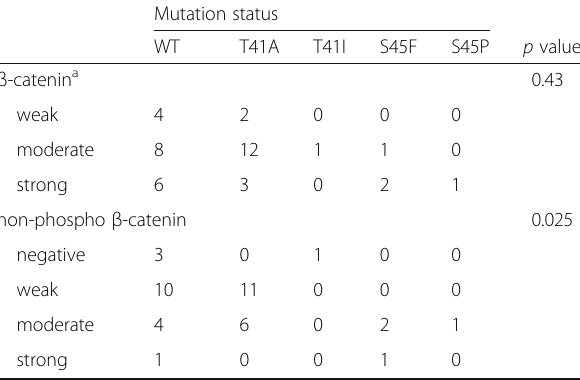
Table 2 Nuclear expression of β -catenin and non-phospho β -catenin. Relationship with CTNNB1 mutation